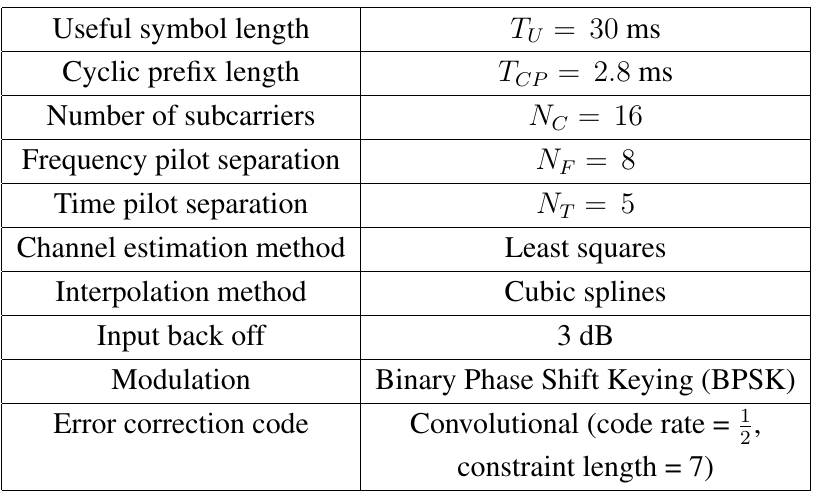
Table 1. Default OFDM parameters